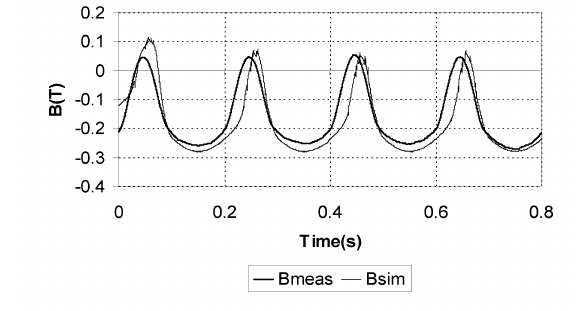
Figure 16: Measured and Simulated Flux Densities